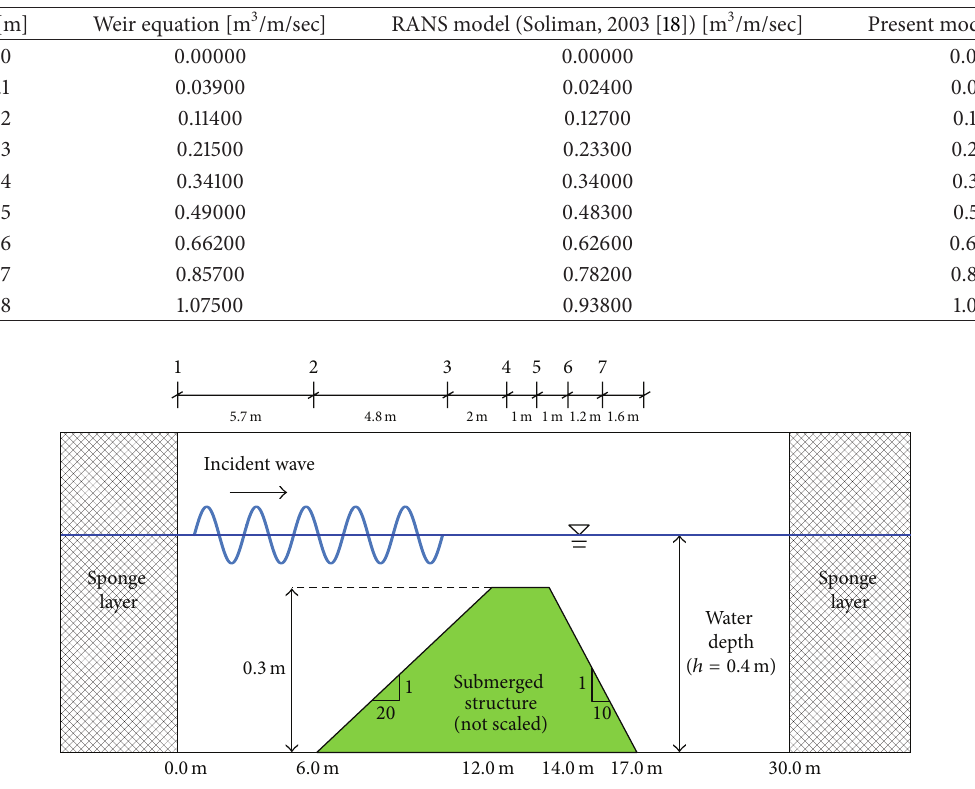
Figure 3: Sketch of the wave channel layout